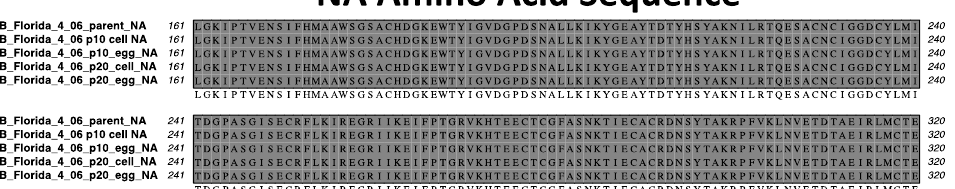
Figure 5. FL/4/06 surface glycoprotein sequence analysis. The HA and NA genes were reverse transcribed into cDNA, PCR amplified, and sequenced using Sanger sequencing. ( A ) The major antigenic sites [35] of the HA protein are shown to be identical to the parental virus. ( B ) The single nucleotide mutation observed between the parental virus and the mouse-adapted HA sequences was a single silent mutation between nucleotide 241 and 320. ( C ) A representative amino acid alignment of the NA protein from positions 161–320 shows 100% sequence conservation between the parental and the mouse-adapted viruses.